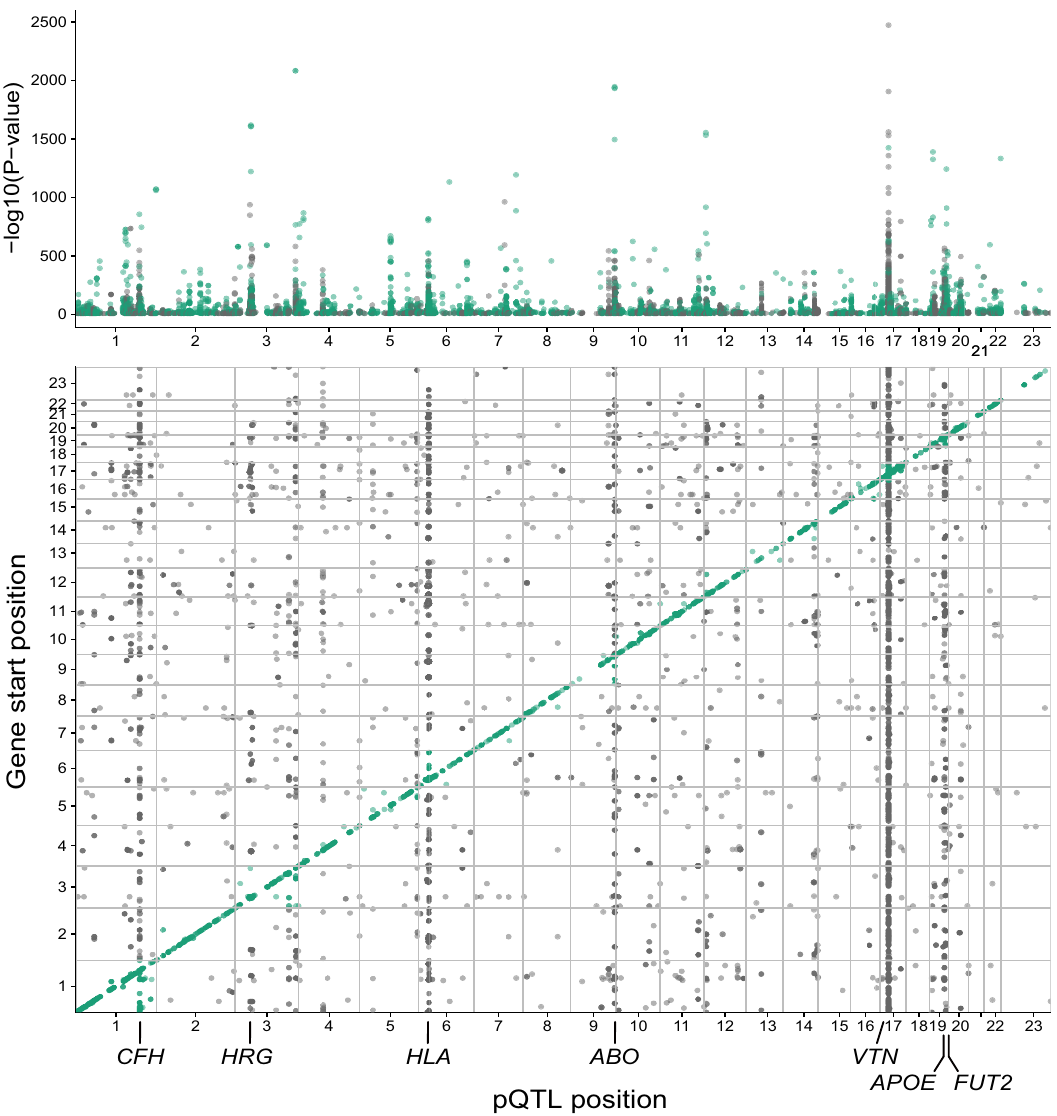
Fig. 2 A graphical representation of all pQTL discoveries in the current study. The Manhattan plot in the top panel uses precise two-sided P -values as − log( P -value) for the association (linear regression) of low-frequency and common exome array variants to 4782 proteins in serum. The bottom panel shows the genomic locations of all study-wide signi fi cant pQTLs (linear regression, P < 1.92 × 10 − 10 , two-sided), also shown in Supplementary Data 1, where the start position of the protein-encoding gene is shown on the y -axis and the location of the pSNP at the x -axis. Cis acting effects, using a 300 kb window, appear at the diagonal while trans acting pQTL effects including trans hot spots show up off-diagonally. The genetic loci highlighted across the x -axis are trans -acting